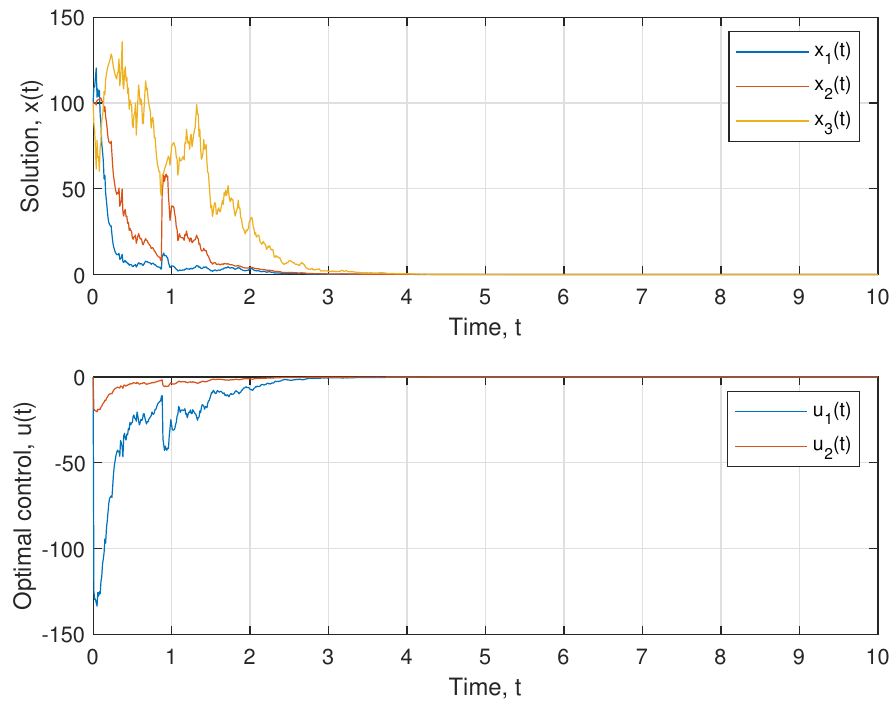
Figure 2. Realizations of solution and optimal control with initial conditions ( 100,100,100 )